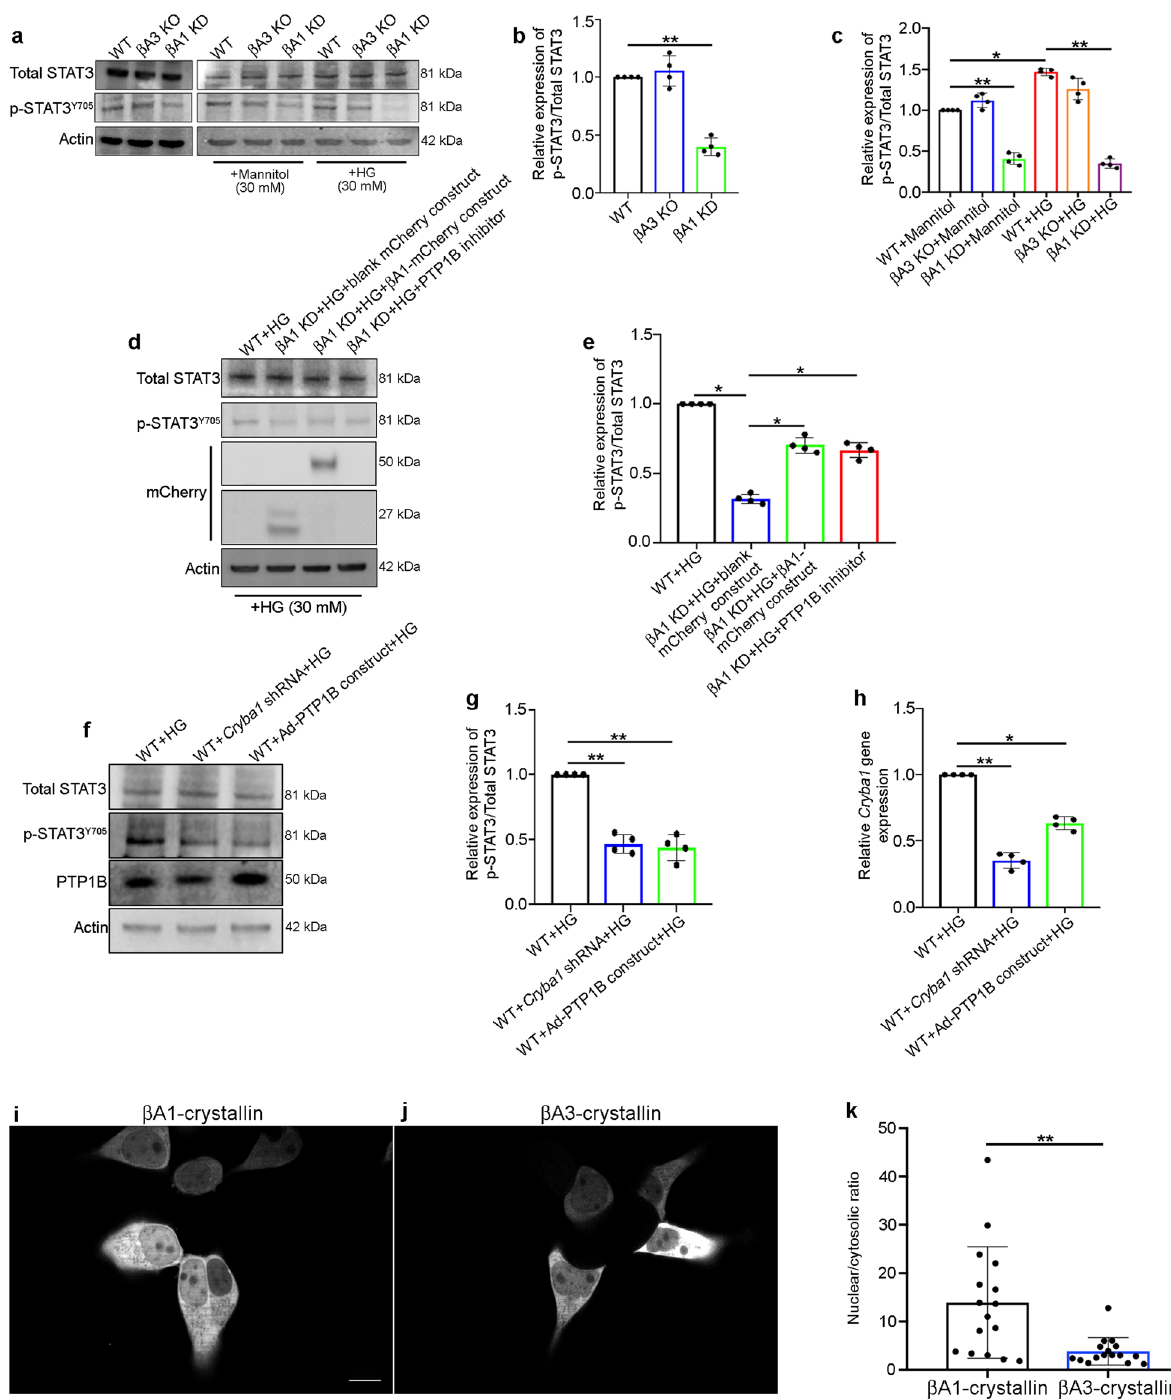
Fig. 4 β A1-crystallin regulates STAT3 nuclear localization. a Representative western blot and b , c densitometry graphs showing decreased phosphorylation of STAT3 at tyrosine 705 (p-STAT3 Y705 ) in β A1 KD astrocytes b untreated or c treated with 30 mM mannitol or high glucose (HG; 30 mM) for 6 h, relative to WT cells ( c ). β A3 KO cells did not show such changes ( a – c ); n = 4. ** P < 0.01. d , e Overexpression of β A1-crystallin (using β A1- mCherry construct) in β A1 KD astrocytes or treatment with 10 μ M PTP1B inhibitor (MSI-1436) for 1 h, prior to HG (30 mM) exposure for 6 h rescued the levels of p-STAT3 Y705 , as compared to β A1 KD cells transfected with blank-mCherry construct. β A1-crystallin overexpression was con fi rmed by mCherry western blot. f Western blot and g densitometry graph showing decrease in p-STAT3 Y705 expression in WT cells infected with Adenovirus-PTP1B overexpression construct or Cryba1 shRNA for 48 h, followed by HG treatment. h Cryba1 knockdown was con fi rmed by qPCR, which showed about 70% downregulation compared to control. n = 4. * P < 0.05, ** P < 0.01. i , j Representative images from live-cell confocal microscopy of human iPSC-derived astrocytes after overexpression of i β A1-mCherry or j β A3-mCherry constructs and k quantitative assessment of nuclear translocation, showing nuclear localization of β A1-crystallin in these cells ( i , k ), whereas β A3-crystallin construct transfected cells showed less nuclear localization ( j , k ). Scale bar, 10 μ m. ** P < 0.01 ( n =